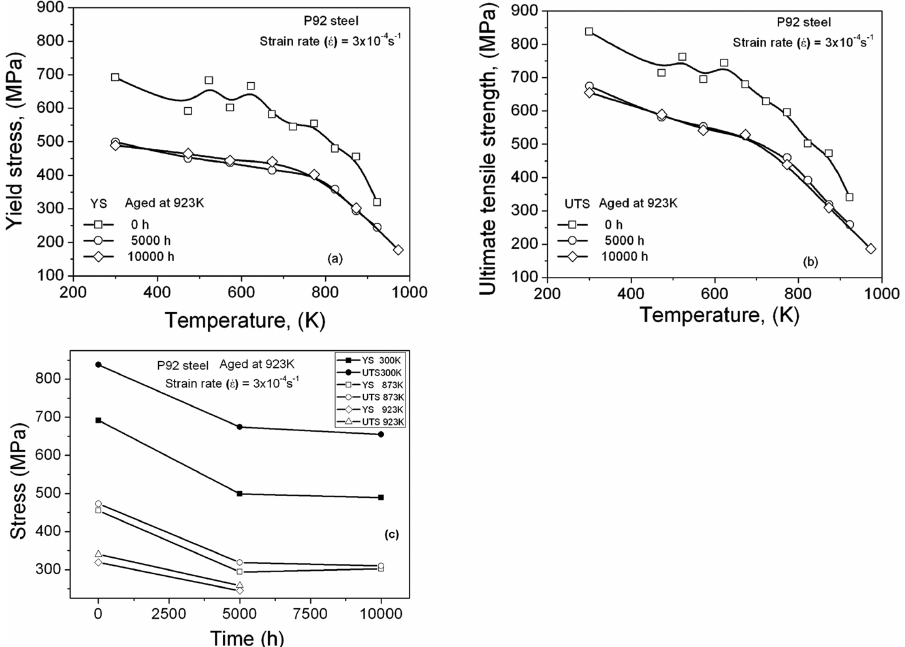
Figure 8: The variation of (a) yield stress and (b) ultimate tensile strength with test temperature of P92 steel in the normalized and tempered, and thermal-aged conditions, (c) YS and UTS with ageing